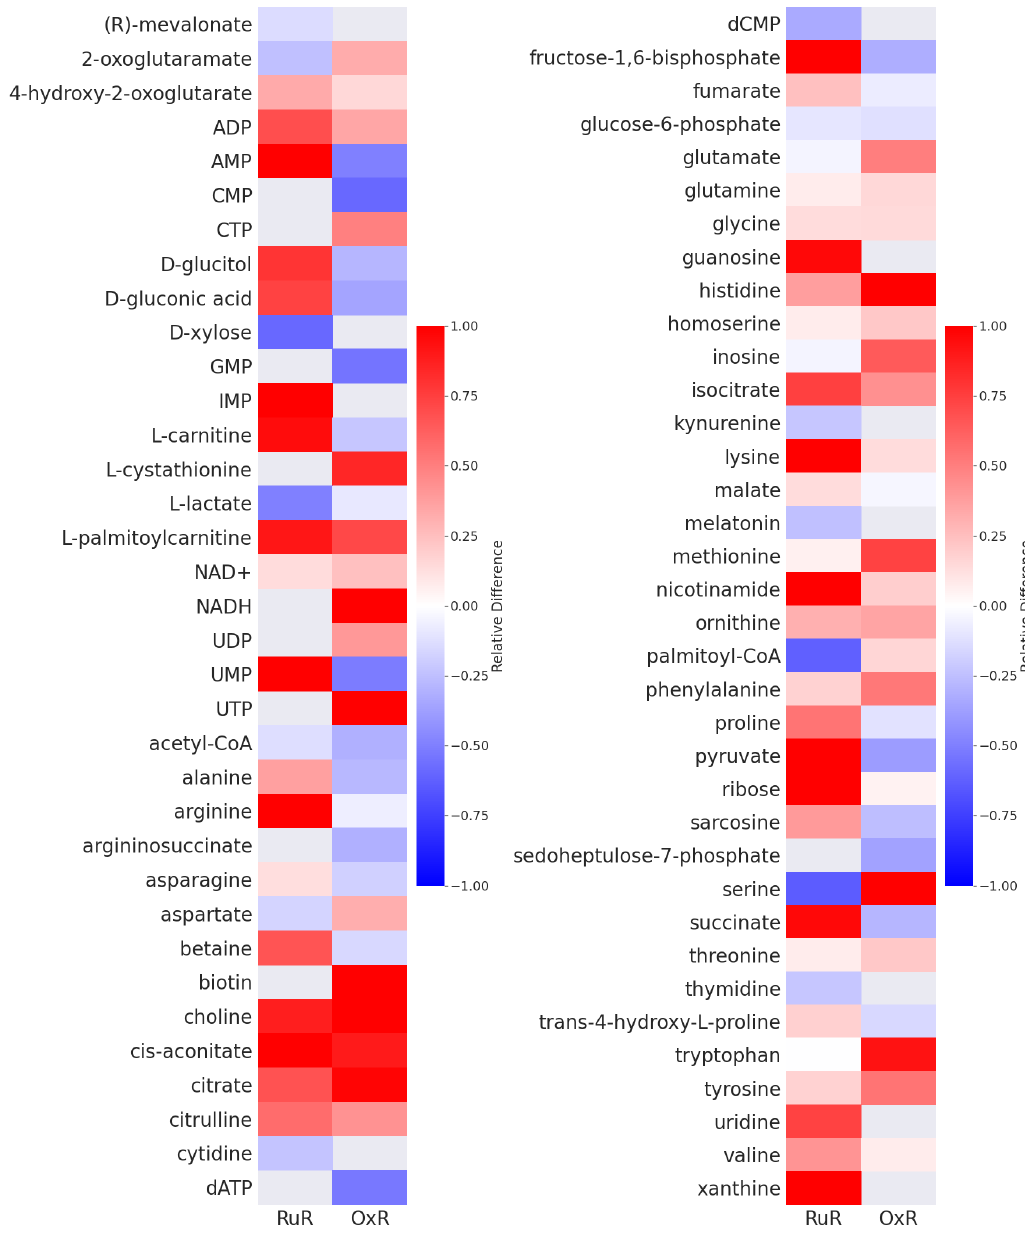
Figure 1. Observed changes in metabolite concentrations upon acquired resistance. Oxaliplatin (OxR) and BOLD- 100/KP1339 (RuR) resistance models are compared to their sensitive counterparts. Relative differences in the measured metabolite concentrations of resistant and sensitive cells are shown. A positive relative difference (red) indicates a higher metabolite concentration in the resistant as compared to the parental sensitive model, whereas a negative relative difference (blue) indicates a lower metabolite concentration in the resistant than in the sensitive counterpart. Relative differences were calculated from using the mean values of six replicates. Only those metabolites for which we observed an absolute relative change greater than 15% between sensitive and resistant, in at least one of the two conditions, are shown. The following